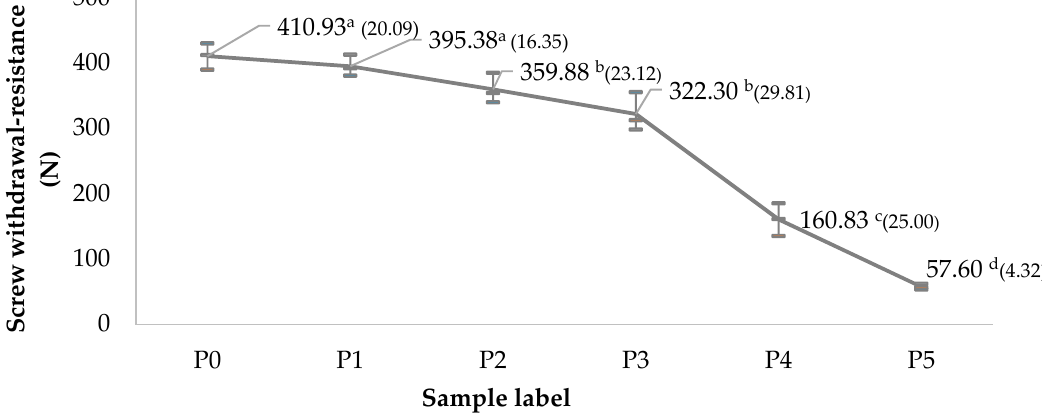
Figure 5. Effect of wood ash replacement rate on the screw-withdrawal resistance of the WCAP (mean